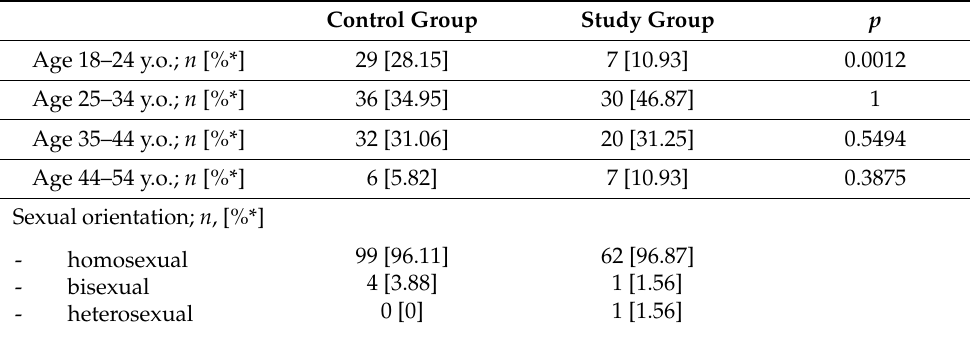
Table 1. Demographic comparison between groups. Control Group Study